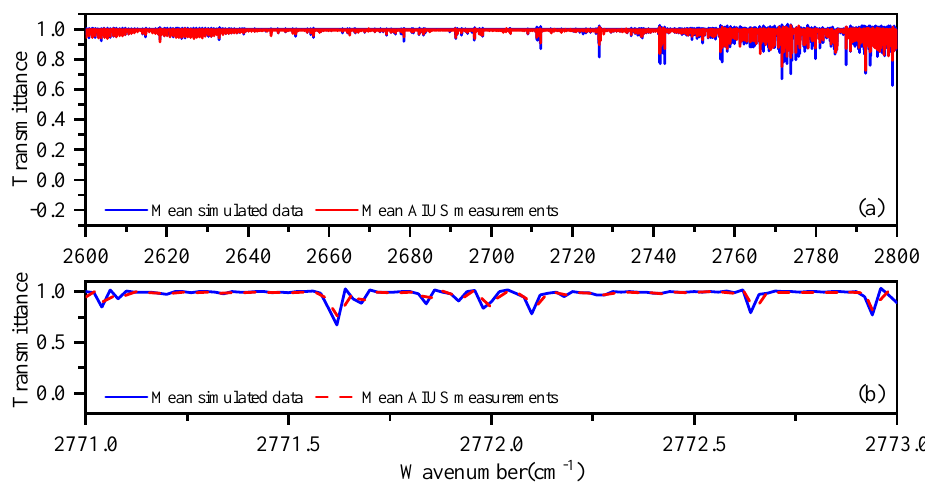
Figure A5. Mean transmittance of AIUS measurements and simulations in 2600–2800 cm − 1 at 40 km. Figure A6 presents the transmittance differences variation with altitudes (15 km, 20 km, 40 km, and 60 km) in 2600–2800 cm − 1 . Figure A6a illustrates that the transmit- tance differences can be ignored at 60 km. Figure A6b illustrates that the transmittance differences were mostly within ± 0.05 in 2600–2750 cm − 1 and ± 0.1 in 2750–2800 cm − 1 at 40 km. Figure A6c illustrates that the transmittance differences were within ± 0.3 at 20 km, with 79% of the differences within ± 0.05. Figure A6d illustrates that the transmittance differences were mostly in the range of − 0.2 to 0.2 at 15 km. In general, the transmittance differences were larger at lower altitudes in 2600–2800 cm − 1